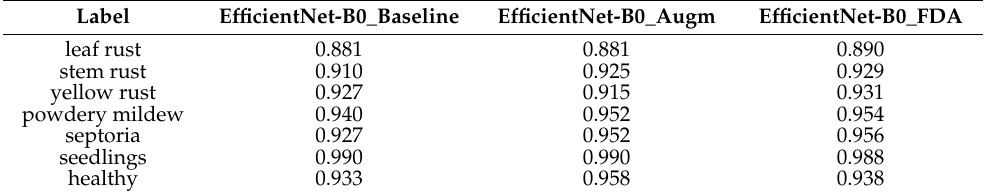
Table 6. Accuracy of determining various types of labels on the test sample for the three used neural strategies of neural network training.